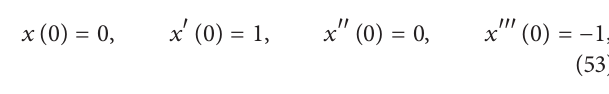
Figure 3: Plots of error functions for (36) and (37); blue: 𝑘 = 5 ; brown: 𝑘 = 10 ; green: 𝑘 = 15 ; red: 𝑘 = 20 : (a) Ext 𝑘 (𝑡) ; (b) Res 𝑘 (𝑡) . 2 − 2𝑡 + (2/3) − (1/81 − where 𝑓(𝑡) = 𝑡(𝑡 2 − (2/3)𝑡 + 1/9) (1/9)𝑡 + (1/3)𝑡 2 − (1/3)𝑡 3 )𝑒 1/81−(1/9)𝑡+(1/3)𝑡 2 −(1/3)𝑡 3